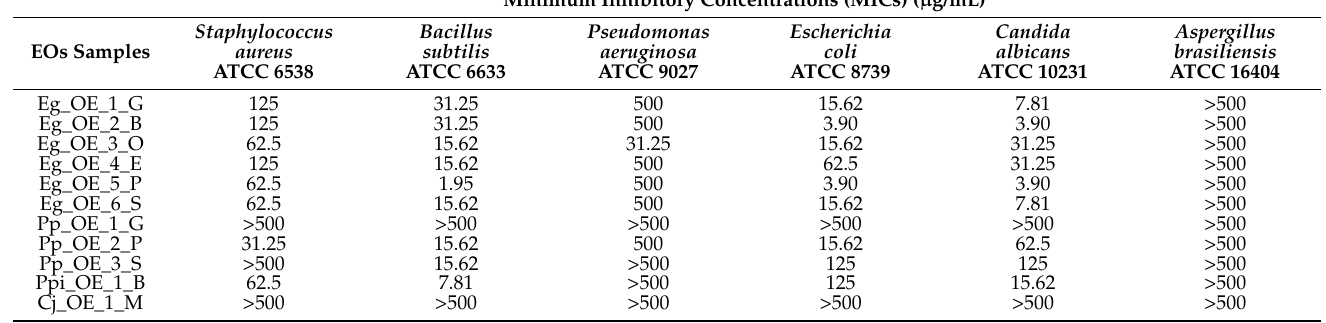
Table 4. Minimum inhibitory concentrations (MICs) of Eucalyptus globulus , Pinus pinaster , Pinus pinea and Cryptomeria japonica essential oils (EOs) against Gram-positive and Gram-negative bacteria, yeast, and mold. For sample codes vide Materials and Methods